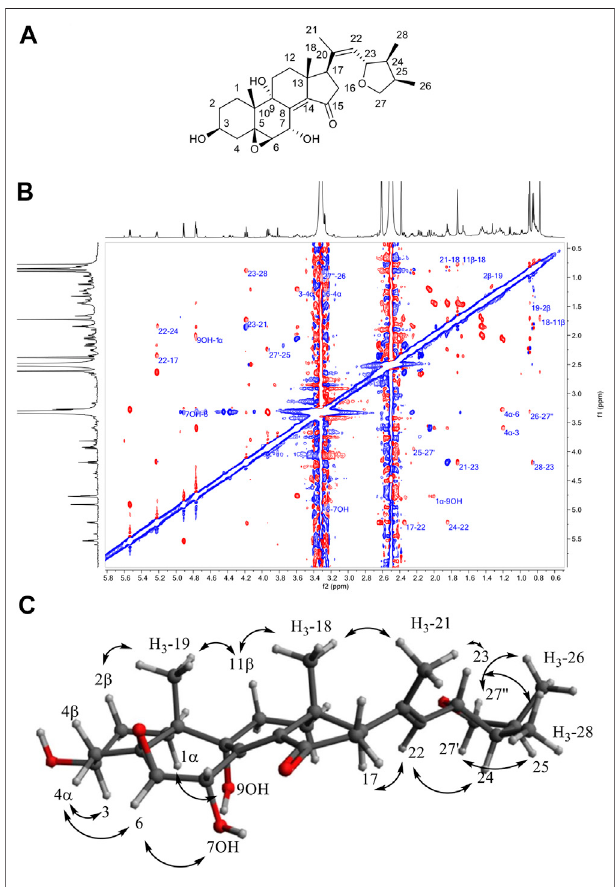
FIGURE 5 | (A) Structure of 12 . (B) ROESY NMR spectrum of 12 in DMSO- d 6 . (C) Observed ROESY correlations for compound 12 .